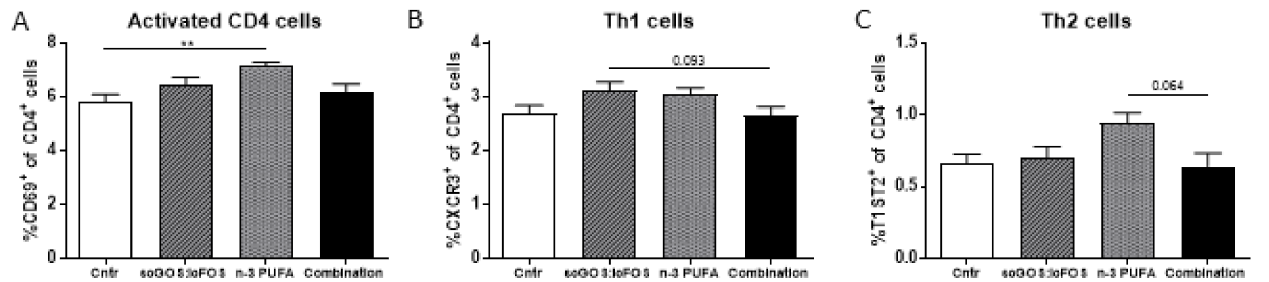
Figure 7. The dietary effect of scGOS:lcFOS, n-3 PUFAs and the combination of scGOS:lcFOS and n-3 PUFAs on activated CD4 cells, Th1 cells and Th2 cells in the MLN. ( A ) The percentage of activated CD4 (CD69 + CD4 + ) cells is significantly increased in the n-3 PUFA group compared to control. ( B ) The percentage of Th1 cells (CXCR3 + CD4 + ) tended to a decrease in the combination diet group compared to the scGOS:lcFOS group. ( C ) The percentage of Th2 cells (T1ST2 + CD4 + ) tended to a decrease in the combination diet group compared to the n-3 PUFA group. An outlier in the control group was excluded by use of ROUT analysis. ( A – C ): Data shown as the mean +/ − SEM. Analysed by one-way ANOVA and Sidak’s multiple comparisons post hoc test. ** p < 0.01. n = 5–10 mice per group, 2 samples in the control group, 3 samples in the n-3 PUFA group and 2 samples in the combination diet group were excluded due to low number of viable cells. Th1: T helper 1 cells. Th2: T helper 2